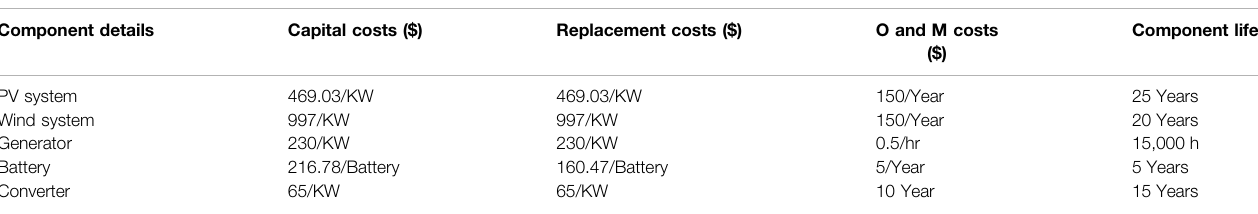
TABLE 6 | Cost details of various